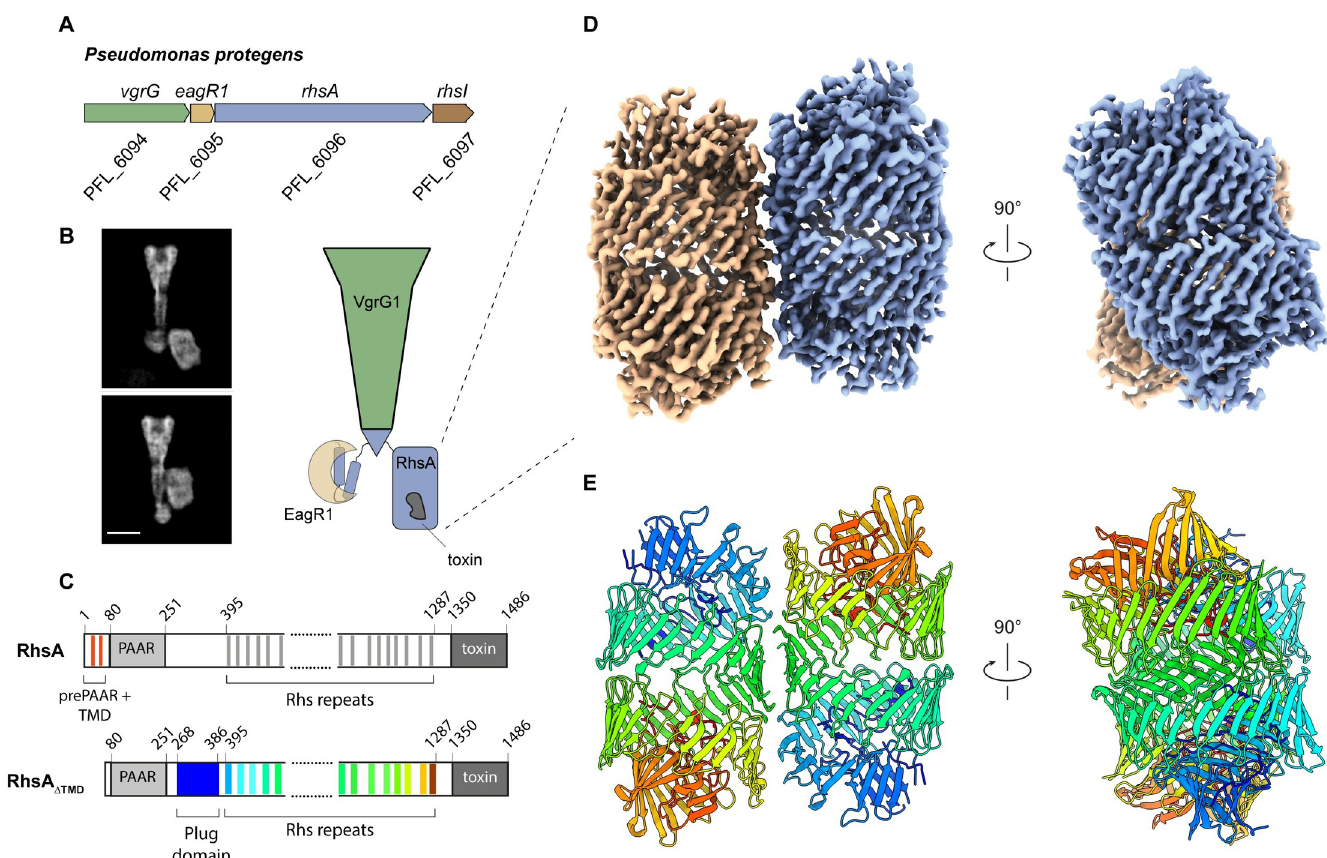
Fig 1. High-resolution structure of the T6SS effector RhsA. (A) Genomic context of rhsA (PFL_6096, blue) in Pseudomonas protegens Pf-5. Upstream genes encoding the cognate VgrG protein, vgrG1 (PFL_6094, green) and RhsA-specific chaperone, eagR1 (PFL_6095, light brown) are shown. Self-protection against RhsA is conferred via expression of the downstream immunity-encoding gene, rhsI (dark brown). (B) Representative cryo-EM 2-D class averages of the assembled pre-firing complex composed of VgrG1, RhsA and EagR1 (left) and a schematic representation of each of the components that comprise this complex (right). Scale bar, 10 nm. (C) Full- length RhsA contains a prePAAR motif and a TMD comprising two transmembrane helices upstream of its PAAR domain. The RhsA Δ TMD truncation of RhsA was used in this study to determine the high-resolution structure of the RhsA cocoon. (D) Cryo-EM density of RhsA Δ TMD displayed perpendicular to the central symmetry axis of the barrel and rotated 90˚ clockwise (map postprocessed with DeepEMhancer). (E) Cartoon representation of the atomic model of RhsA colored in rainbow from N-terminus (blue) to C-terminus